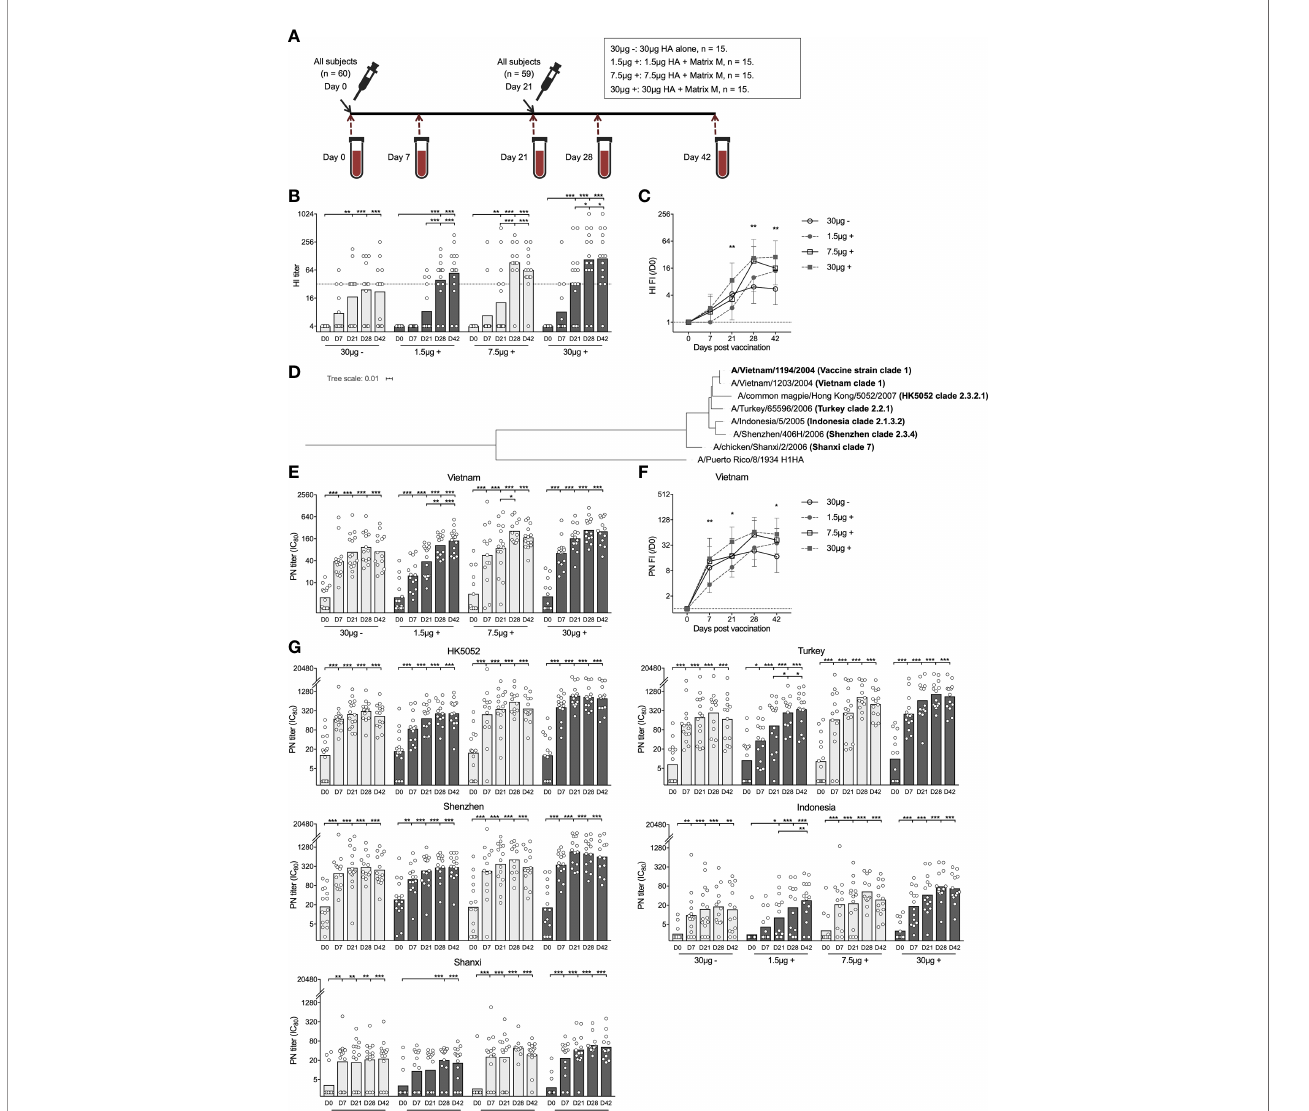
FIGURE 1 | Adjuvanted H5N1 vaccine rapidly elicited strain speci fi c and cross-reactive neutralizing antibody responses. (A) An Illustration of the study design. Sixty adults (20 to 49 years old) were enrolled in this study and vaccinated with inactivated virosomal H5N1 vaccine (Crucell| Berna Biotech, Switzerland). The adults were randomized into 4 groups of 15 subjects and received two doses of H5N1 vaccine with 30 m g hemagglutinin (HA) alone (30 m g -), or 1.5, 7.5 and 30 m g HA adjuvanted with Matrix M (1.5 m g +, 7.5 m g +, and 30 m g +, respectively), at an interval of 21 days. Serum samples pre- (day 0), 7 days, 21 days, 28 days, and 42 days post-vaccination were collected. One subject withdrew after fi rst dose vaccine in 7.5 m g + group. (B, C) Hemagglutination inhibiting titer (HI titer, B ) and fold- induction (FI) after vaccination (HI FI,/D0, C ) was measured against NIBRG-14 virus (vaccine strain). (D) Phylogenetic tree shows the genetic divergence between H5HA from the vaccine strain and heterologous H5HAs tested in pseudotype-based neutralization (PN) assay. H1HA from A/Puerto Rico/8/1934 was used as a reference. Phylogenetic analyses were performed at ngPhylogeny.fr. (E, F) Vaccine speci fi c neutralizing antibodies were measured in PN assay against pseudotyped virus derived from A/Vietnam/1203/2004 virus (Vietnam). The PN titer (IC 80 , E ) was calculated as the reciprocal dilutions of the sera that gave 80% inhibition. Fold- induction after vaccination (PN FI,/D0, F ) is shown. (G) Cross-neutralizing antibody titers (IC 80 ) were measured against 5 strains of pseudotypes expressing heterologous H5HAs listed in D All antibody responses were measured using serum samples before (D0) and after vaccination (D7, D21, D28, and D42). The geometric mean values are shown as bars, and each symbol represents one subject (B, E, G) . The geometric mean of fold-inductions in each group ± geometric standard deviation as error bar is shown (C, F) . *P < 0.05, **P < 0.01, ***P < 0.001 (Antibody titers and fold-inductions were Ln transformed in statistical analyses. Turkey ’ s multiple comparisons between pre-prime (D0) and post-prime (D7, D21, D28, D42), and between pre-boost (D21) and post-boost (D28 and D42) in each group were performed in two-way ANOVA in (B, E, G) Turkey ’ s multiple comparisons between 30 m g + and 1.5 m g + after prime (D7 and D21), and between 30 m g + and 30 m g - after boost (D28 and D42) were performed in two-way ANOVA in C, F ). The horizontal dotted lines indicate HI titer of 32 (B) , and fold-induction of 1 (C, F) . Duplicates were performed in all